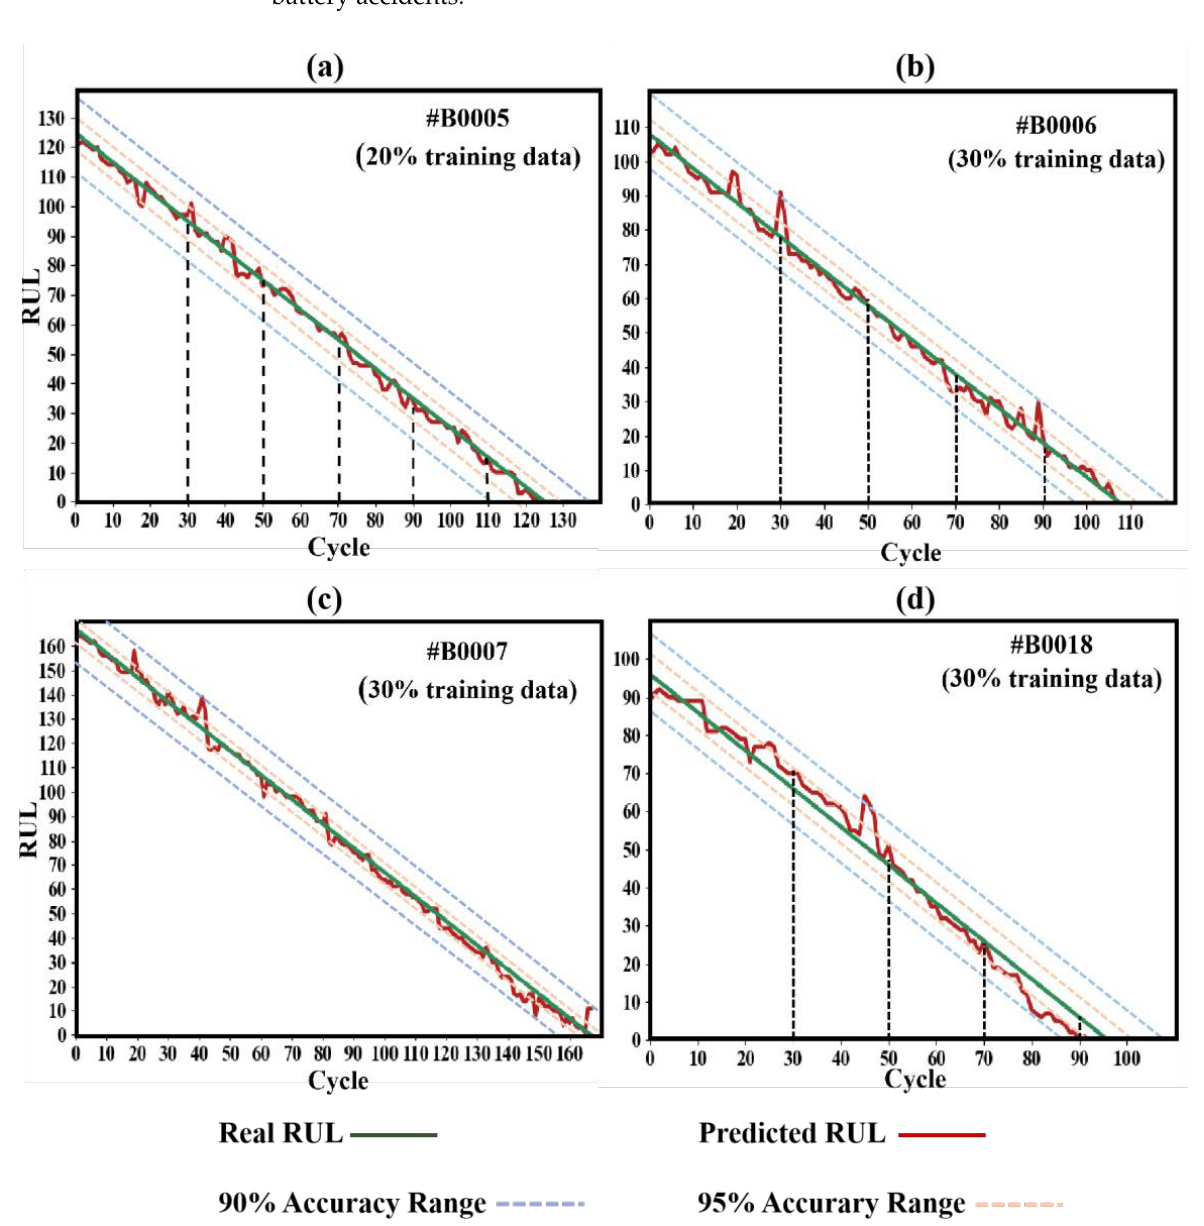
Figure 3. The SR model of the predicted and real RUL of batteries #5 ( a ), #6 ( b ), #7 ( c ), and #18 ( d ), discharged at 2A and 24 °C, respectively.